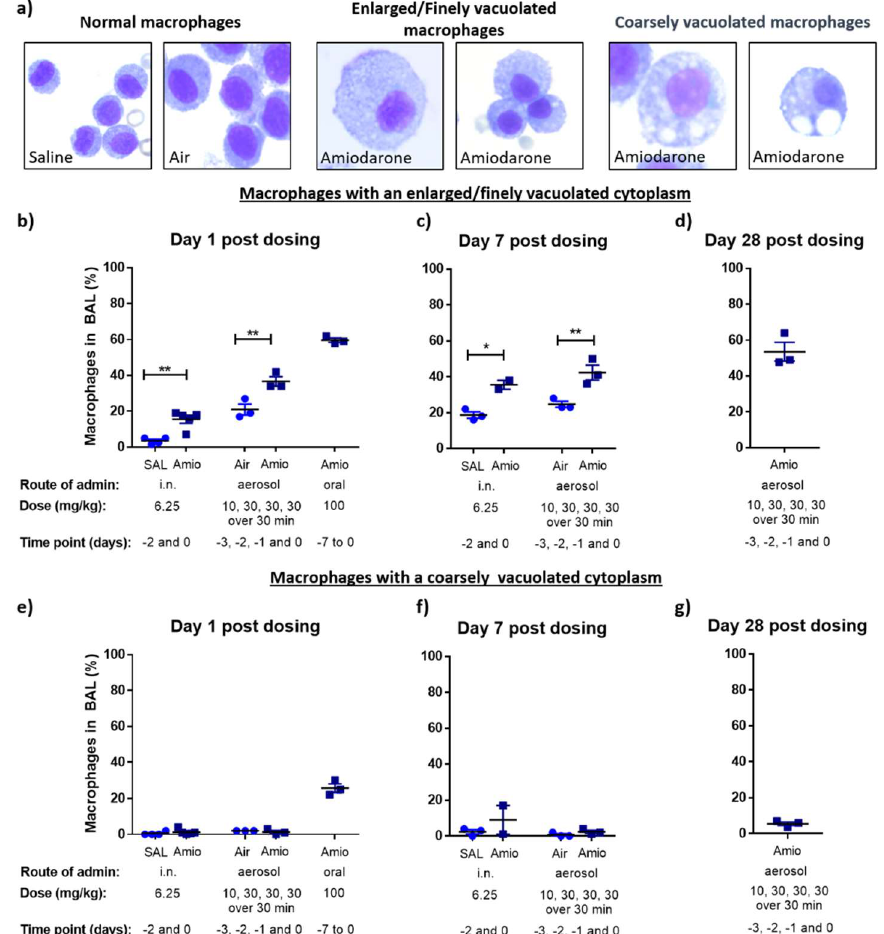
Figure 2. Morphological evaluation of BAL macrophages using light microscopy. ( a ) Representative images (63 × magnification) showing macrophages from control animals (left image), enlarged macrophages with a finely vacuolated cytoplasm (centre image) and macrophages with a coarsely vacuolated cytoplasm (right image). The prevalence of macrophages with finely vacuolated cytoplasm ( b – d ) and coarsely vacuolated cytoplasm ( e – g ), expressed as a percentage of the total macrophage population at day 1, day 7 and day 28 post-dosing with vehicle control (saline (SAL) or air) and amiodarone. Data represents mean ± standard error of the mean (SEM) ( n = 2–5 per treatment group); * p < 0.05, ** p < 0.01, statistically significant compared to respective control, two-way ANOVA with post hoc Bonferroni test, difference from untreated cells.